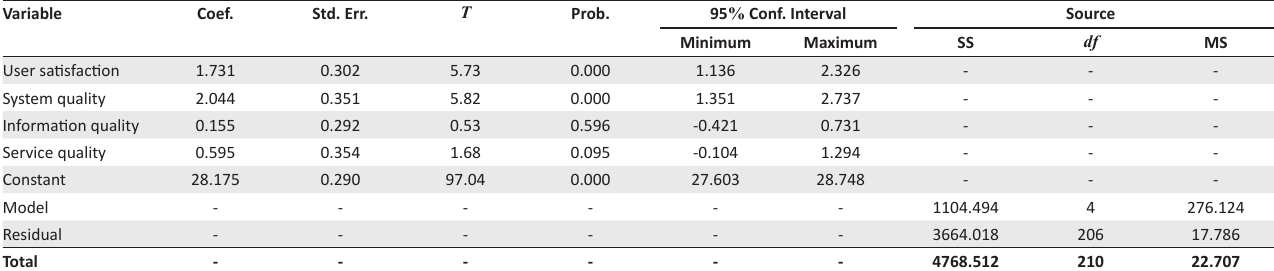
TABLE 4: Regression model for net benefits (without interaction terms). Variable